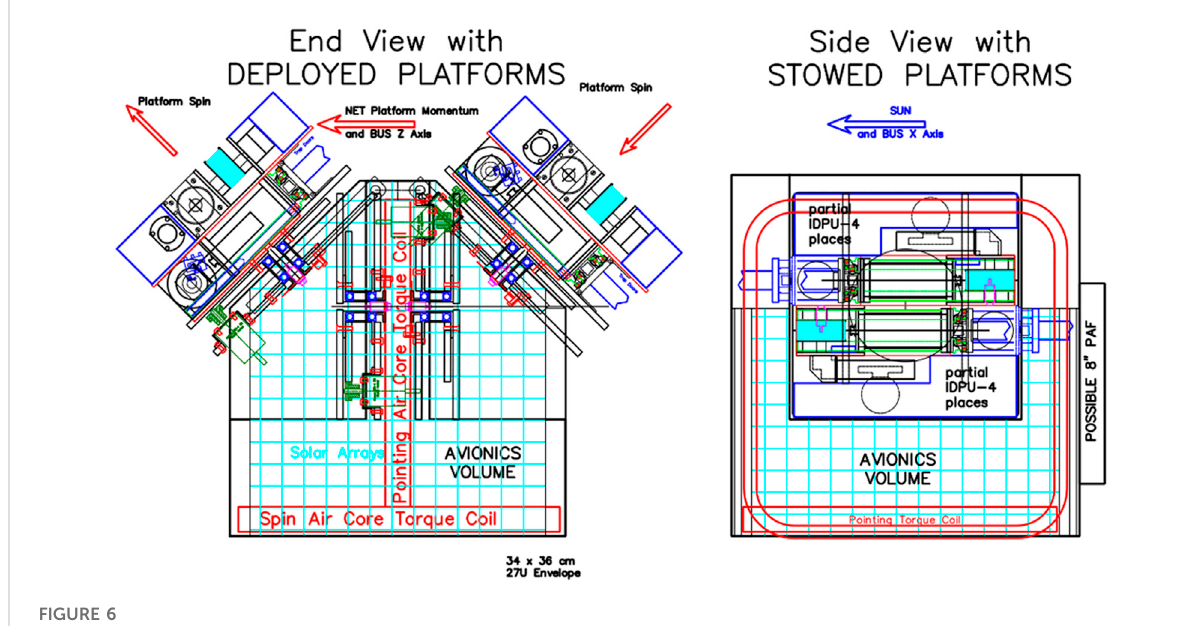
FIGURE 6 27U bus